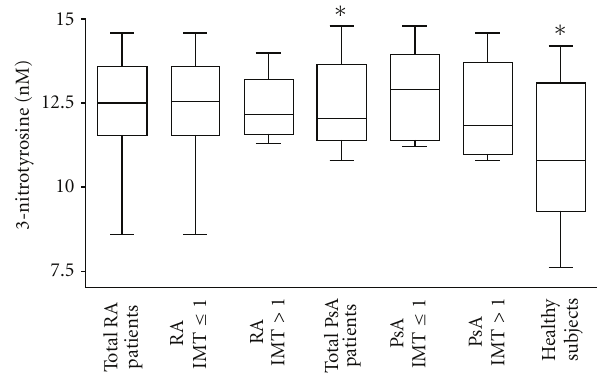
Figure 3: 3-Nitrotyrosine concentrations in serum samples . Box plot graphs showing 3-nitrotyrosine concentrations in serum samples from the 24 patients with rheumatoid arthritis (RA) and the 25 patients with psoriatic arthritis (PsA), divided or not according to IMT values obtained by Echo-colour Doppler images and from the 13 healthy subjects. ∗ P = 0 .